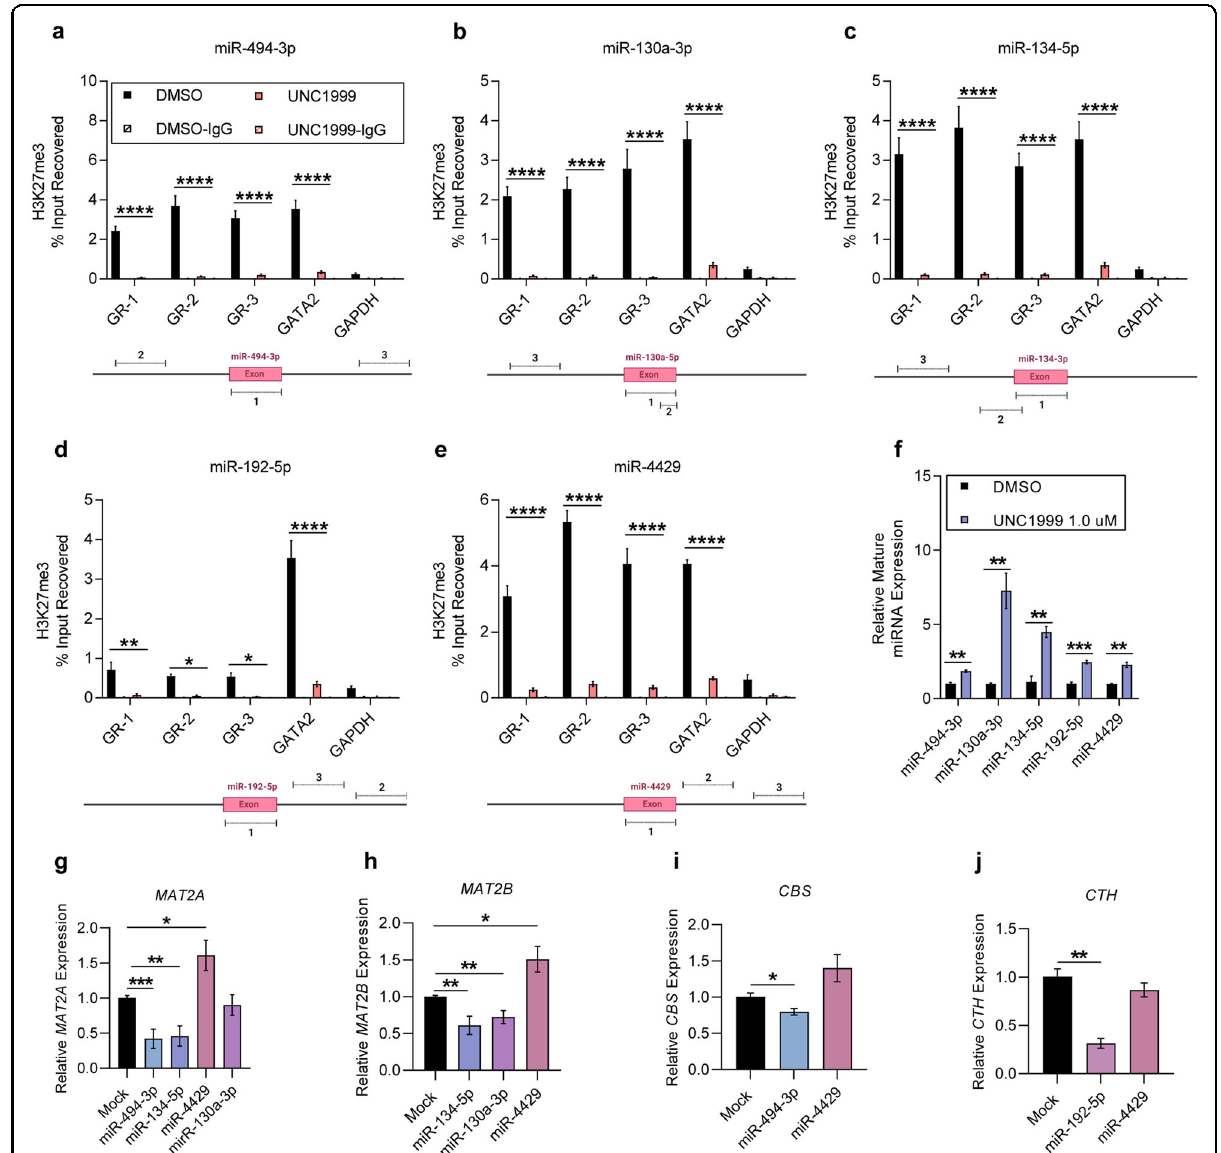
Fig. 4 UNC1999 increased the expression of miRNAs that regulate methionine cycling-associated genes. a – e ChIP-qPCR analysis of H3K27me3 enrichment in UNC1999-treated INA-6 cells on exonic and gene body regions of a miR-494-3p, b miR-130a-3p, c miR-134-5p, d miR-192- 5p and e miR-4429. For each miRNA, we analysed three genomic regions (GR-1, GR-2, GR-3). The location ampli fi ed by each primer pair is shown below every graph. Statistical analysis was performed with two-way ANOVA. GATA2 and GAPDH were used as positive and negative controls for H3K27me3 enrichment, respectively. The experiments were performed in three biological replicates. Values: mean with SEM. f RT-qPCR analysis of fi ve PRC2-targeted miRNAs in INA-6 cells, post-UNC1999-treatment. Data were generated in three biological replicates. Value: mean with SEM. g – j MCF7 cells were transfected with 5 nM of miR-494-3p, miR-130a-3p, miR-134-5p, miR-4429 and miR-192-5p mimics. RT-qPCR analysis of methionine cycling- associated genes after 48 h of miRNA mimic treatment for g MAT2A, h MAT2B, i CBS and j CTH. miR-130a-5p or miR4429 were used as negative controls. Statistical analysis was performed with two-tailed t -test. Values: mean with SEM. Data were collected from three biological replicates. * p < 0.05, ** p < 0.01, *** p < 0.001, **** p <